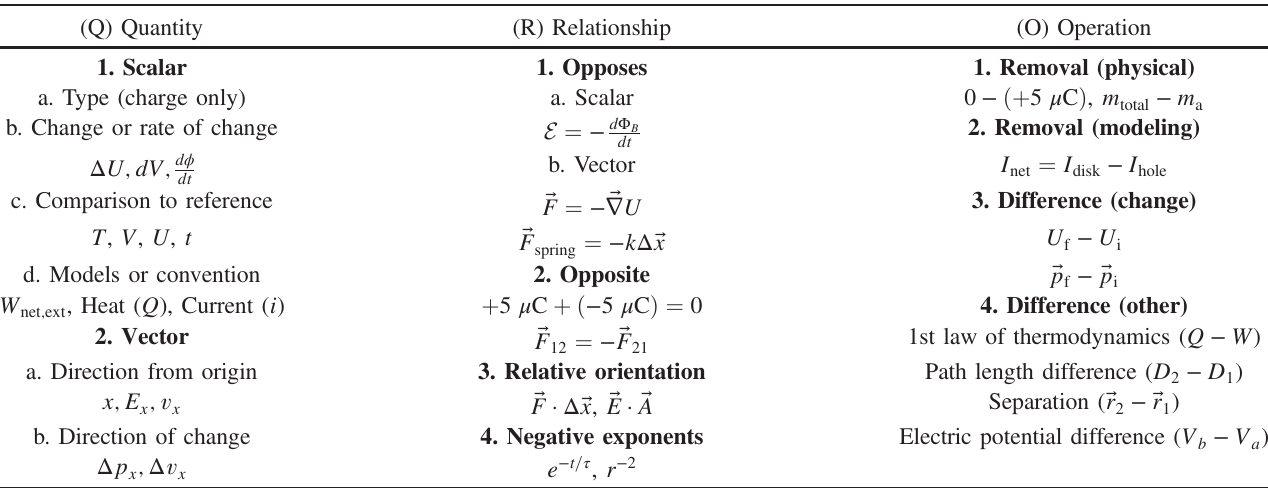
TABLE III. Current version of the natures of negativity in introductory physics, a framework for the different uses of the negative sign in introductory physics. The top row includes the three natures. The subnatures are organized into groups, shown bolded in the table. Some groups contain only one